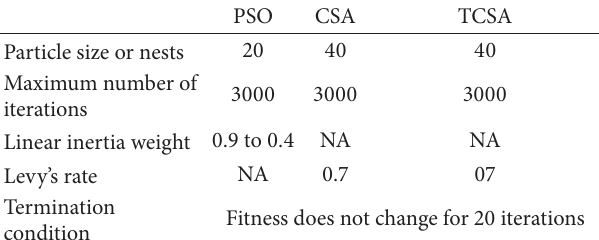
Table 2: Parameter settings for PSO and CSA optimization meth-